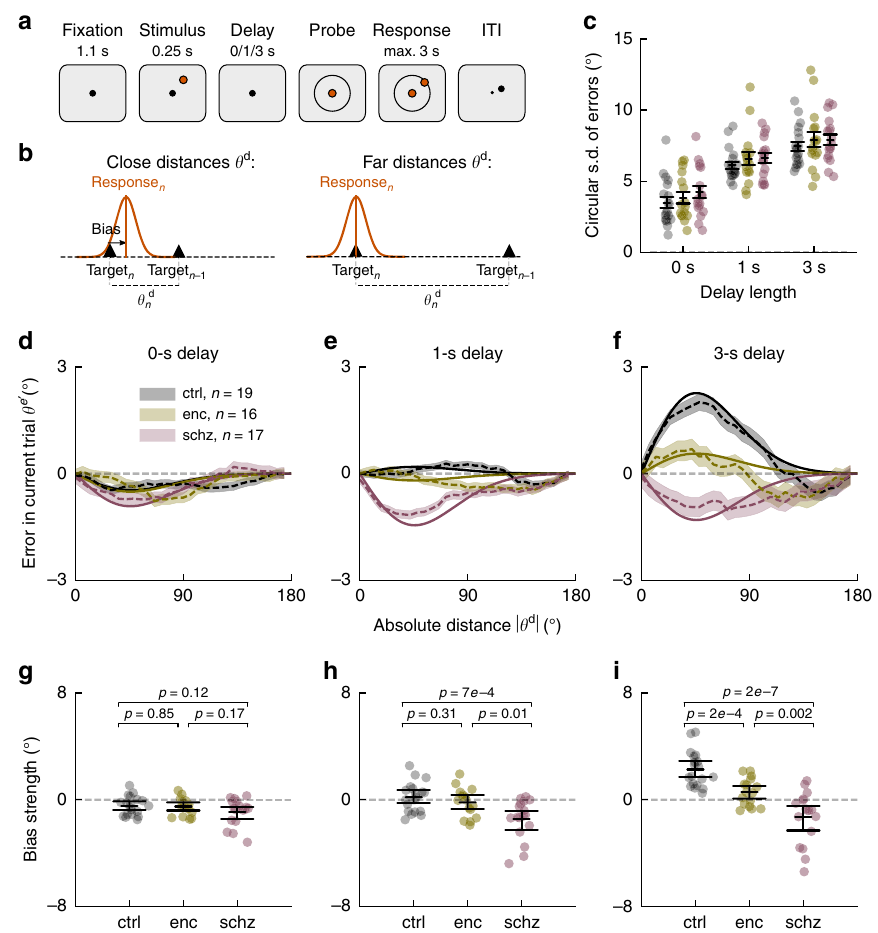
Fig. 1 Reduced working memory-dependent serial dependence in anti-NMDAR encephalitis and schizophrenia. a In each trial, subjects were to reme- mber a stimulus that appeared for 0.25 s at a randomly chosen circular location with fi xed distance from the center. Delay lengths varied randomly between trials (0, 1 or 3 s). Subjects made a mouse click to report the remembered location and started the next trial by moving the mouse back to the screen ’ s center during the inter-trial-interval (ITI). b Serial dependence is measured as a systematic shift of responses towards previous target locations. Attractive effects depend on the distance θ d between previous and current stimulus. c Precision for each subject and delay was inversely estimated as the circular s.d. of bias-corrected error distributions ( “ Methods ” ). For longer delays, participants ’ responses were less precise (delay, F(2,147) = 76.87, p < 1e − 16). There were no overall or delay-dependent group differences in precision (group, F(2,147) = 1.74, p = 0.18; group × delay, F(4,147) = 0.07, p = .99, all p -values from ANOVA). Error bars indicate ±s.e.m. d – f , Serial dependence by group and delay length. Serial dependence is calculated as the ‘ folded ’ error θ e 0 for different θ d (dashed lines; “ Methods ” ). Solid lines show linear model fi ts ( “ Methods ” ), omitting intercepts and negative values of θ d . Shading, ±s.e.m. across pooled trials from n = 19 healthy controls (ctrl), n = 17 patients with schizophrenia (schz), and n = 16 patients with anti-NMDAR encephalitis (enc). g – i Individual (random coef fi cients; dots) and group estimates of serial bias strength ( fi xed effects; error bars indicate mean and bootstrapped 95% C.I. of the mean) by delay. g Serial dependence was repulsive in 0 s trials (DoG( θ d ), F(1,52) = 12.67, p = 0.0008), independently of group (group × DoG( θ d ), F(2,52) = 0.46, p = 0.63). h For 1 s trials, group differences in serial dependence emerged (group × DoG( θ d ), F(2,48) = 6.52, p = 0.003) between ctrl